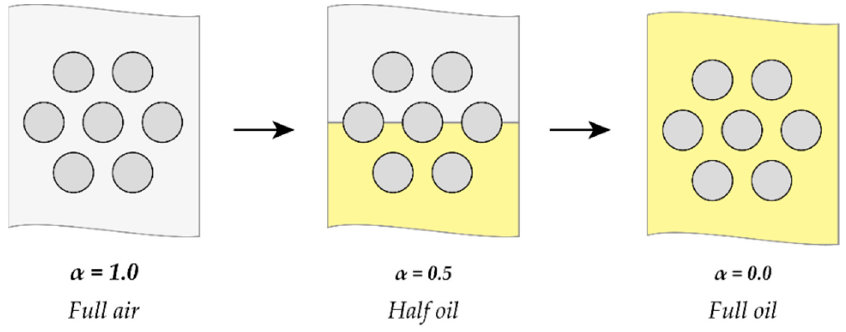
Figure 28. Schematic diagram of the calibration procedure.